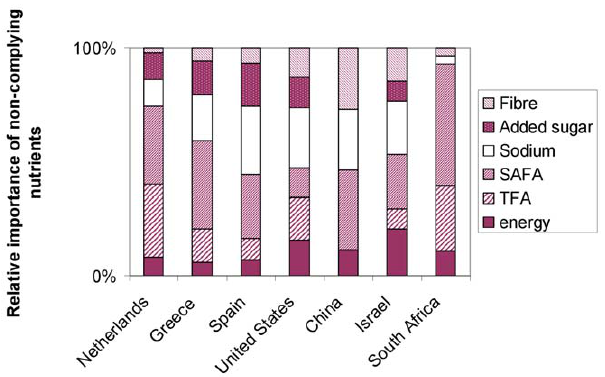
Figure 3. For the replaced foods: which key nutrient did not comply (% of total). Per country the relative importance of the non- complying key-nutrients in the replaced foods is shown. This is expressed as percentage of all non-complying nutrients. This is calculated for each key-nutrient by dividing ‘‘the amount of foods that were non-compliant for the key-nutrient’’ by ‘‘the sum of all non- complying key-nutrients for all foods’’. It must be noted that foods can be non-compliant for more than one